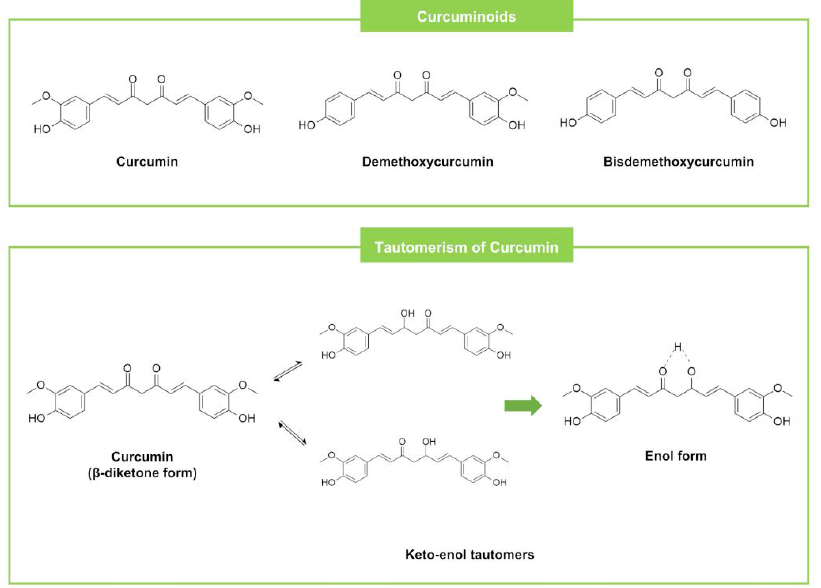
Figure 8. Representative chemical structures of curcuminoid compounds, and tautomerism of curcumin.